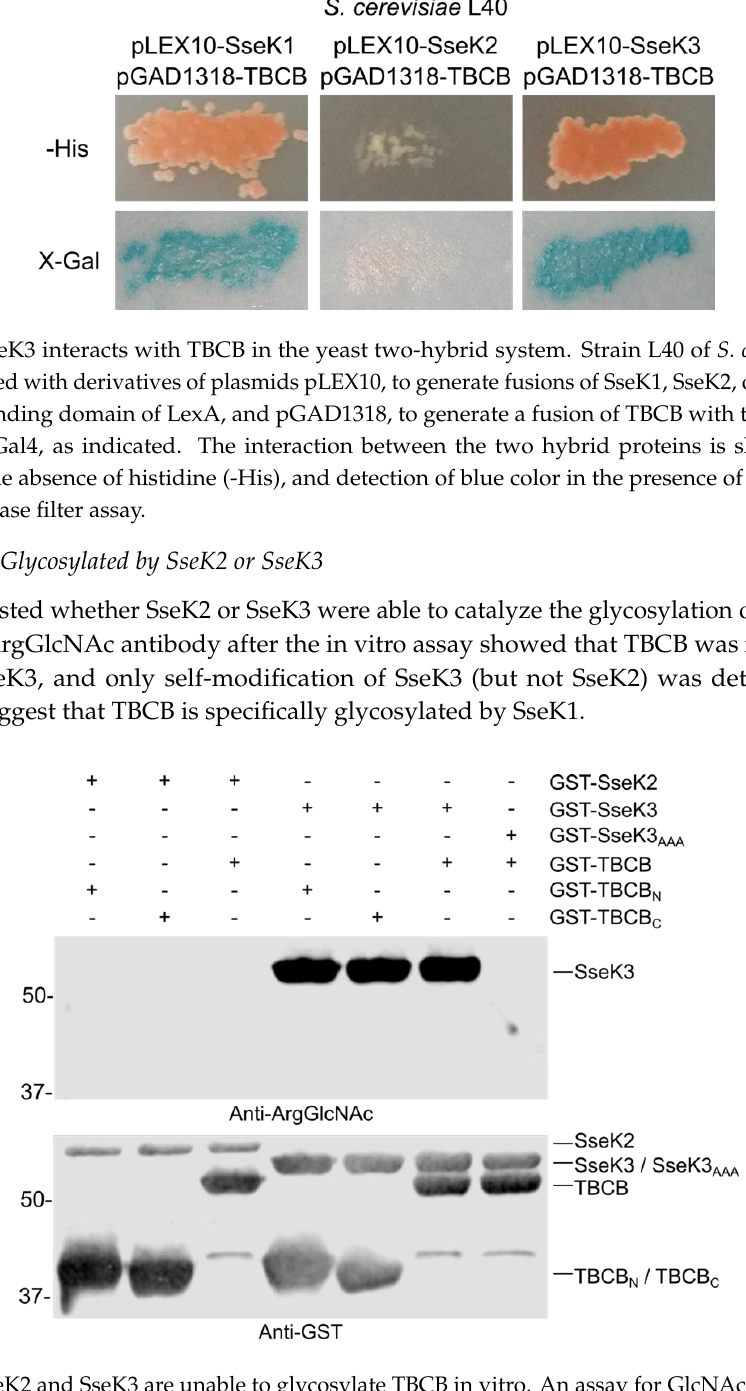
Figure 6. SseK2 and SseK3 are unable to glycosylate TBCB in vitro. An assay for GlcNAc modification of TBCB in the presence of SseK2 or SseK3 using recombinant GST fusion proteins in the indicated combinations and 1 mM UDP-GlcNAc. SseK3 AAA : SseK3(D226A/D228A). TBCB N : N-terminal fragment of TBCB (amino acids 1–125). TBCB C : C-terminal fragment of TBCB (amino acids 126–244). An immunoblot incubated with anti-Arg-GlcNAc is shown (upper panel). The same blot was reincubated with anti-GST (lower panel). Molecular weights in kDa are indicated on the left.